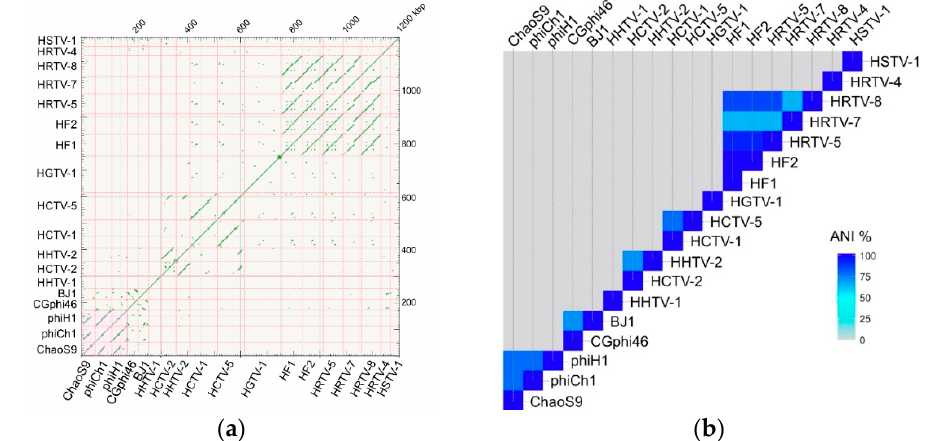
Figure 4. Comparison of the ChaoS9 genome with the genomes of 17 other published halovirus isolates. ( a ) Dot plot showing sequence similarity using the method of zPicture (Blastz) [32]. Names of viruses are shown along lower and left edges, and their lengths are indicated by the pink dashed lines. The scale, in kbp, is shown along the upper and right edges. The pink shaded box at lower left highlights the similarity between ChaoS9, phiCh1 and phiH1. ( b ) Average Nucleotide Identity (ANIb) heatmap. ANIb percentage values were calculated using EZbiocloud [33] and the heatmap produced using heatmapper [34]. Color scale indicates % ANIb.